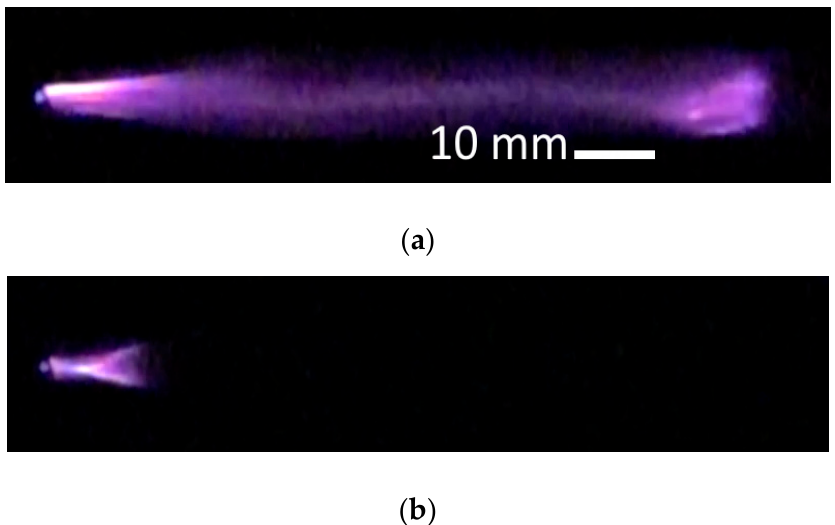
Figure 3. The HCPJ generated at an input power of 400 W and pressure of 40 kPa ( a ) or 100 kPa ( b ). Images taken from a 1000 fps video record with the single frame exposure time of 1 ms.